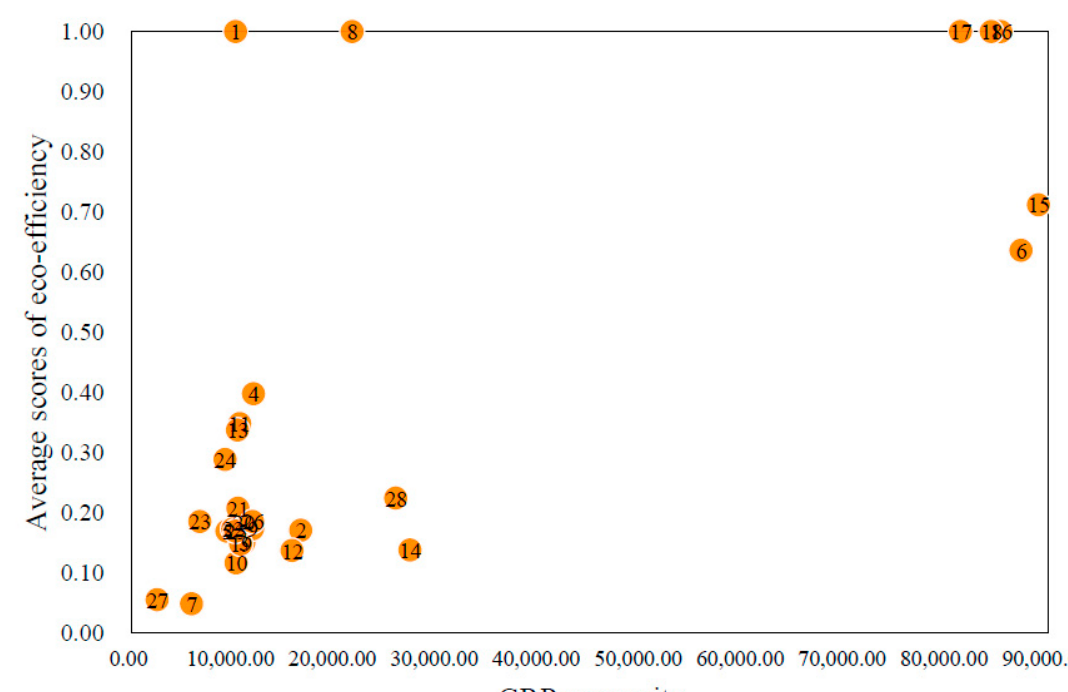
Figure 6. The relationship between GRP per capita and eco-efficiency of the cities along the NSR. Note: the number on the orange point in Figure 6 are the numbers in the “No.” column of Table 3, which represent the respective cities.